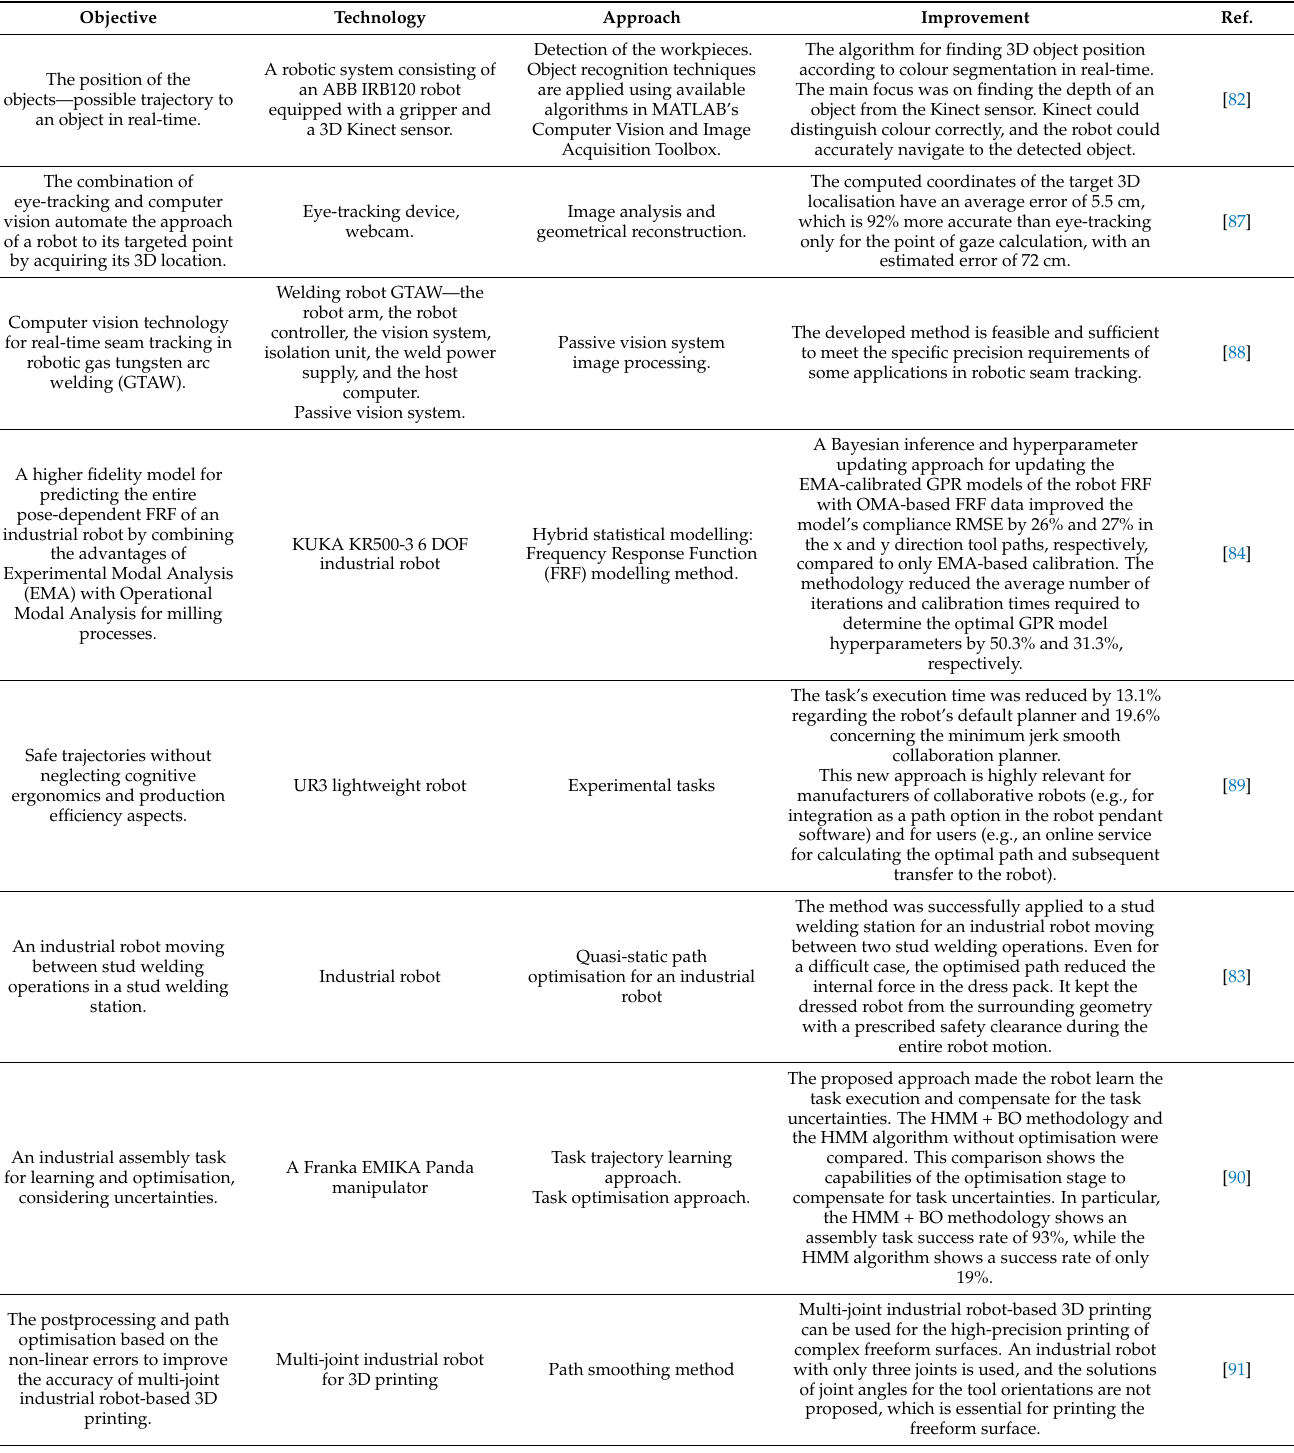
Table 5. Research focused on path planning and